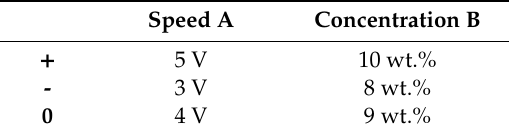
Table 2. Two factors and three levels for each factor